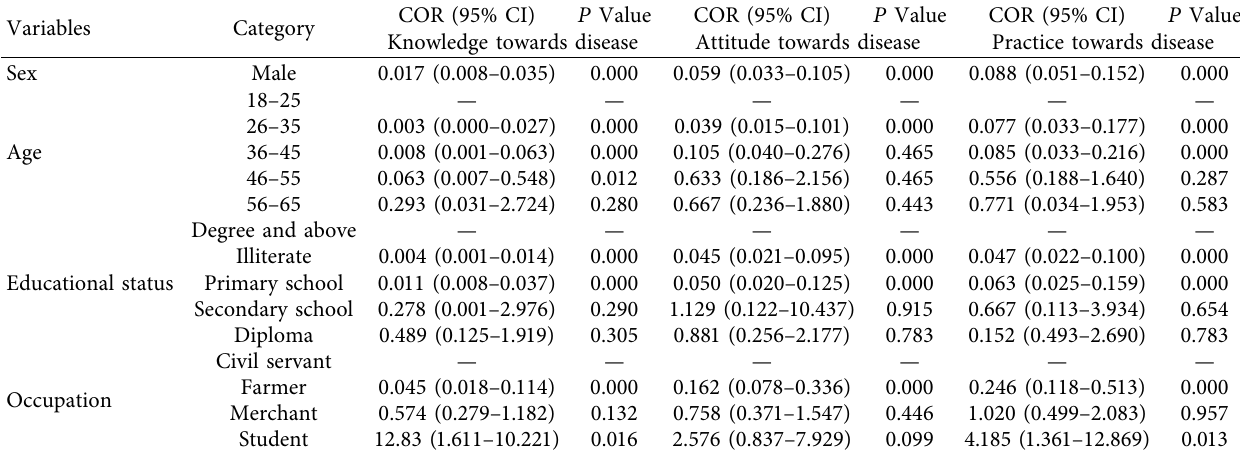
Table 6: Results of the bivariate binary logistic regression analysis of knowledge, attitude, and practice towards the elimination of on- chocerciasis from Gesha town, Ethiopia.